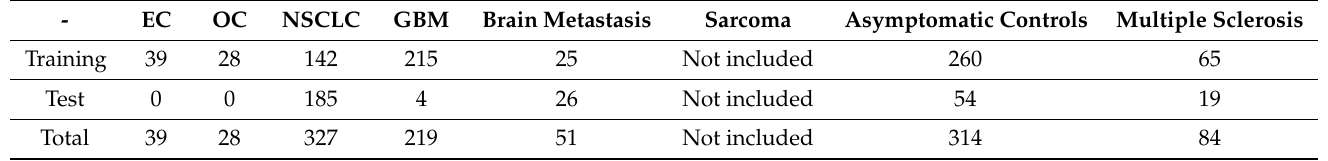
Table 2. Dataset split for the transfer to a new